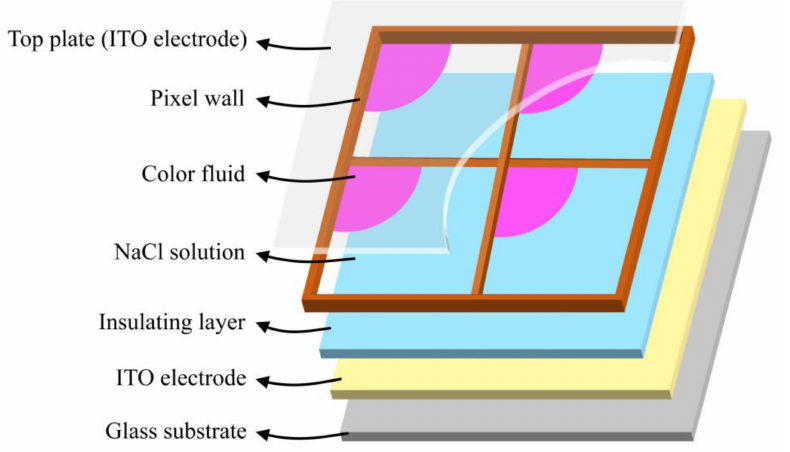
Figure 1. The spatial structure of an EFD in the shrinkage state of oil film. It is composed of a top plate, pixel walls, NaCl solution, color oil film, an insulating layer, two ITO electrodes and a glass substrate. The pixel shows the color of the substrate when a voltage is applied.